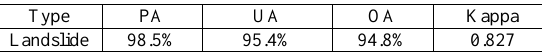
Table 2 Accuracy analysis of landslide identification results